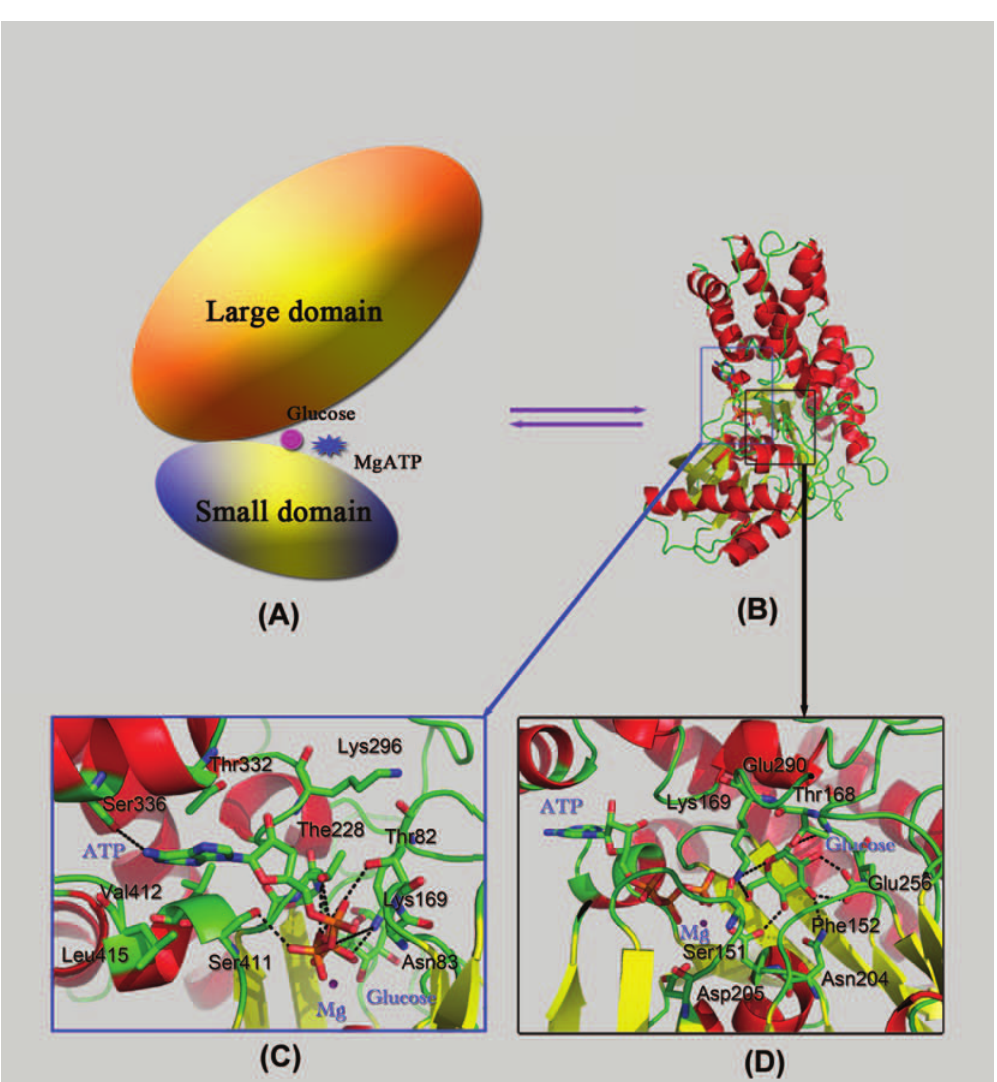
Figure 1. The structural model of GMAG complex. (A) 2D topological structure plot of GMAG. (B) 3D structure of GMAG. (C) Important interactions between ATP and GK. (D) Important interactions between glucose and GK. ATP, Mg 2 + , glucose and important residues in GK are displayed in stick and labeled. Black dashed lines represent hydrogen bonds or salt bridges.